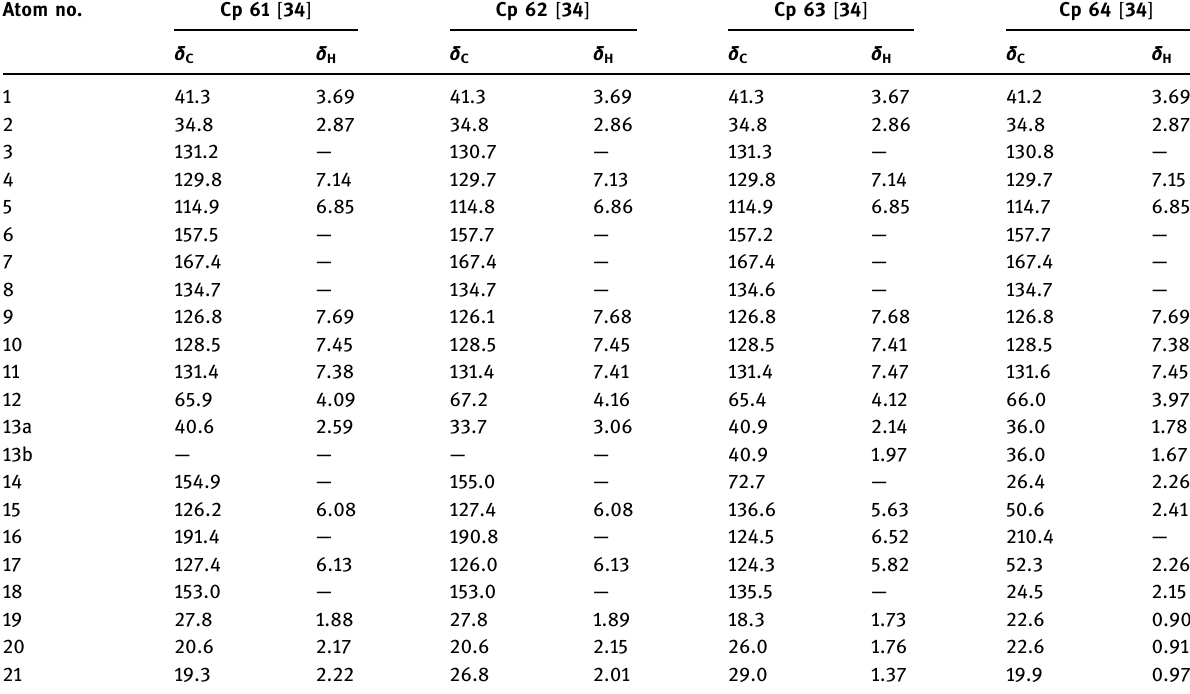
Table 19: 13 C and 1 H NMR chemical shift data ( δ , ppm ) of N - benzoyltyramide derivatives isolated from genus Casimiroa Atom